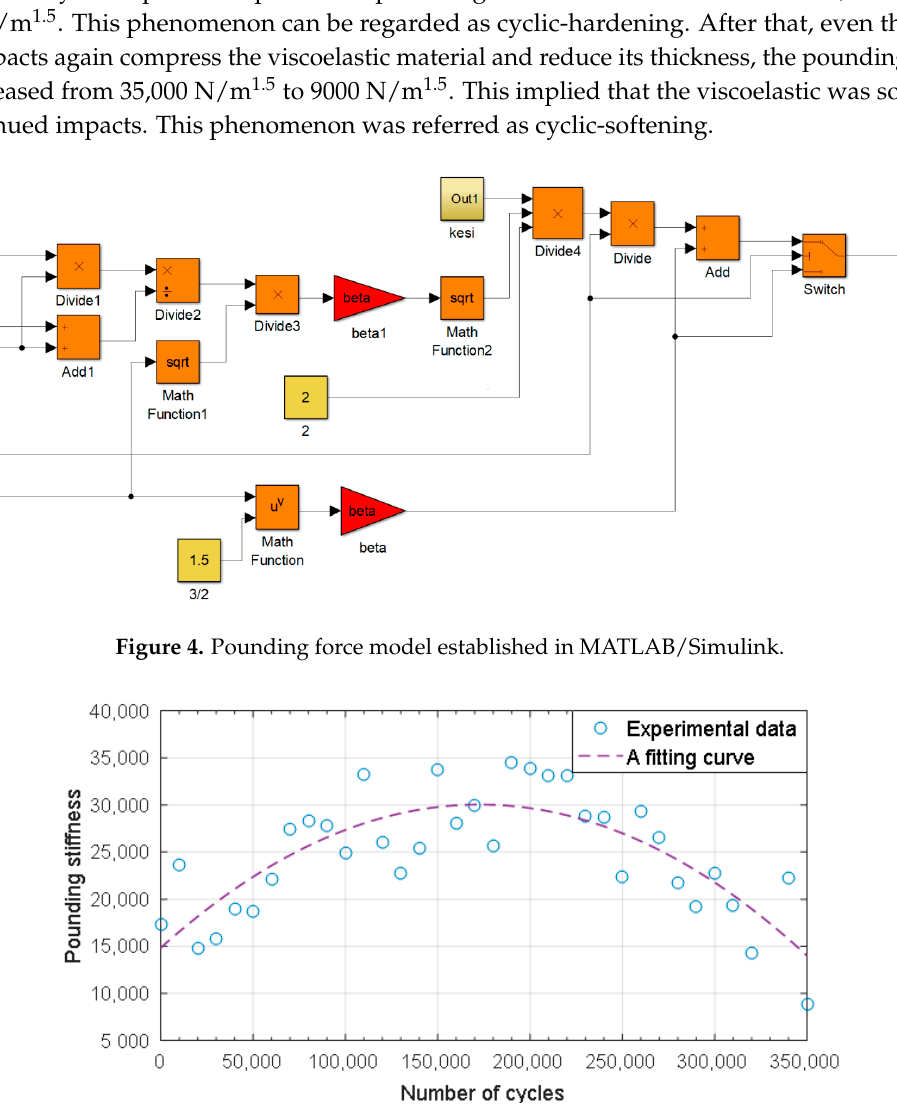
Figure 5. Pounding stiffness after cyclic impacts.